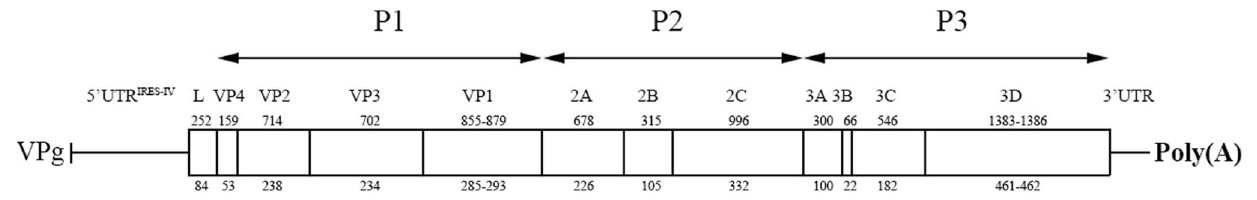
Figure 2. Genome organization of the porcine sapelovirus (PSV). The open reading frames are flanked on either side by UTRs. The numbers above or under each rectangle are the length of nucleotides or deduced amino acids. The length of VP1 and 3D regions are different among PSVs.